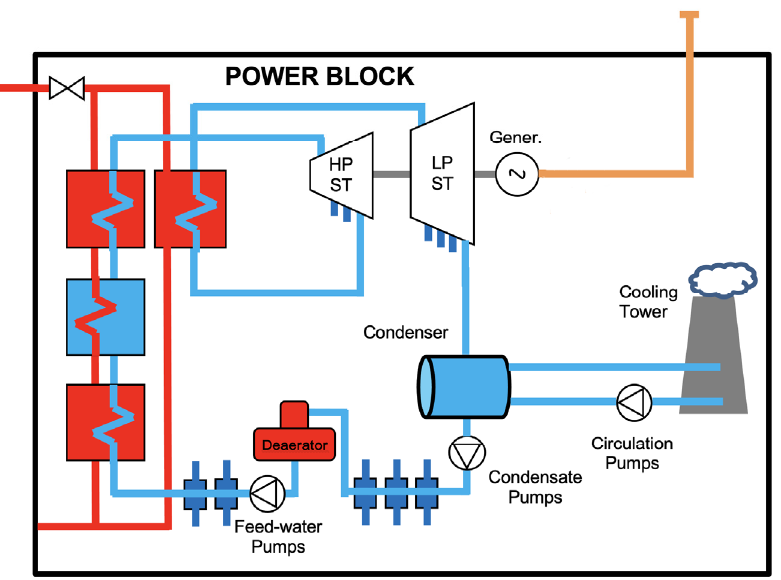
Figure 2. PB Figure 2. PB diagram.